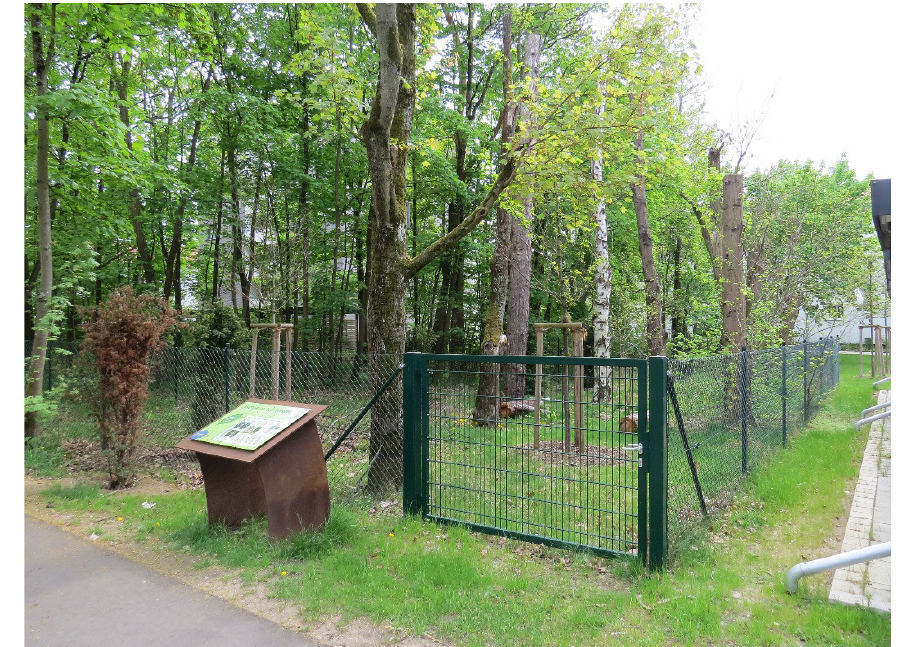
Figure 5. Replantation site of valuable habitat trees felled elsewhere in the